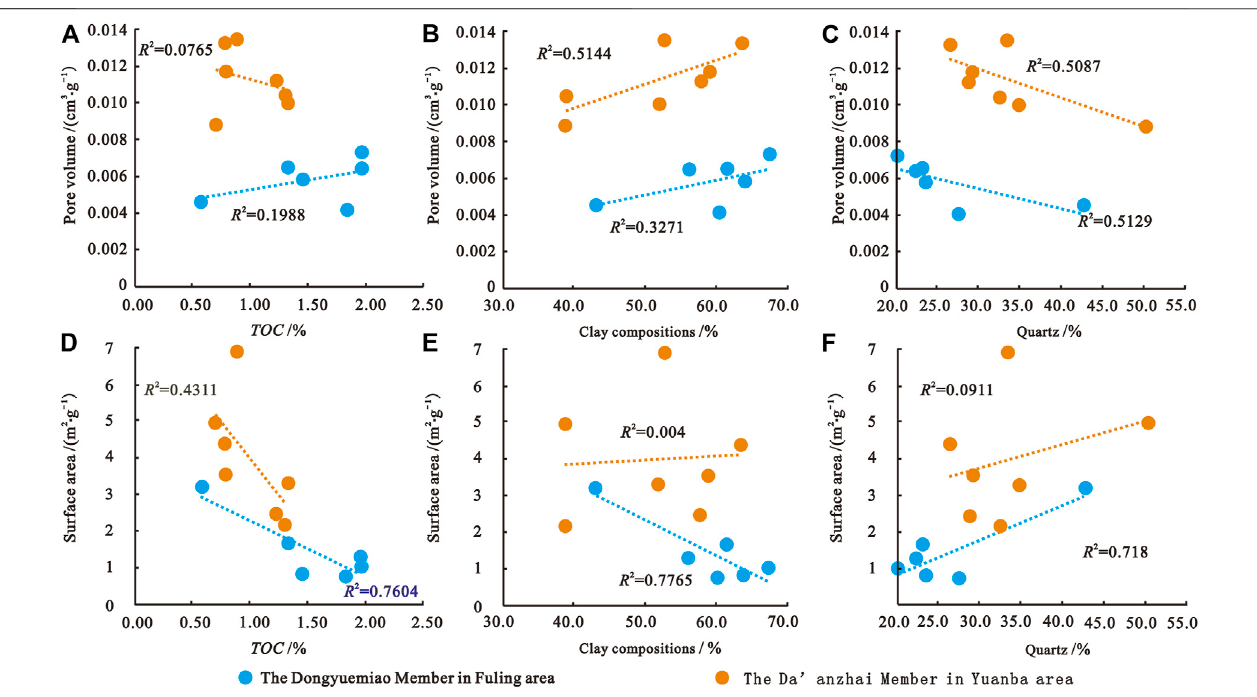
FIGURE 10 | Relationship between pore structure parameters and TOC and mineral content of Ziliujing Formation in northeastern Sichuan Basin. (A) Relationship between pore volume and TOC ; (B) Relationship between pore volume and clay compositions; (C) Relationship between pore volume and quartz; (D) Relationship between surface area and TOC ; (E) Relationship between surface area and clay compositions; (F) Relationship between surface area and quartz.